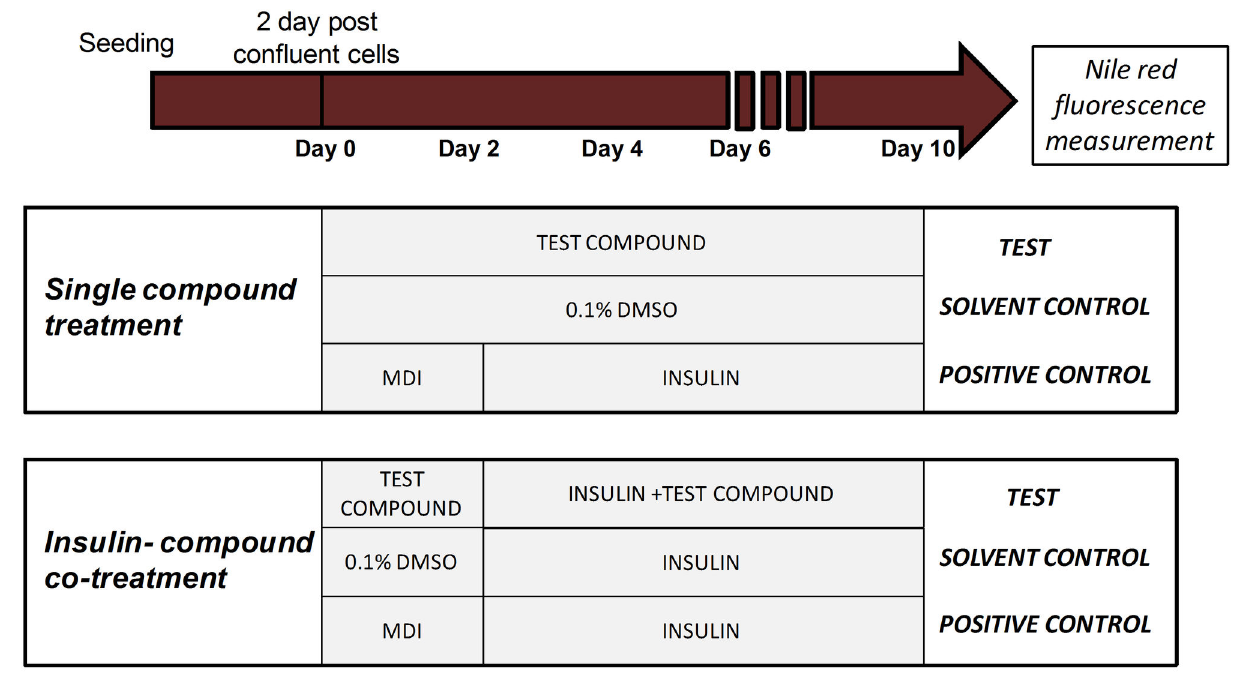
Figure 1. Overview of the experimental setup of one compound and insulin-compound co-treatment experiment of the 3T3-L1 cells. Medium was changed every 2-3 days. Insulin: 10 µg/mL insulin; MDI: 10 µg/µL insulin, 0.25 µM dexamethasone and 0.5 mM isobutylmethylxanthin